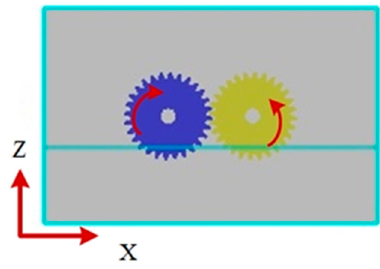
Figure 5. Model of a gearbox in sinusoidal motion.